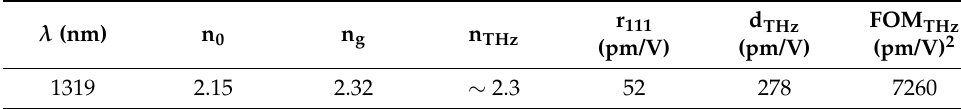
Figure 15. Optimum crystal length l opt ( ν , λ ) for the generation of THz waves as a function of the pump optical wavelength, and the frequency of the generated THz wave for OH1 for both pump and THz waves polarized along the polar axis. Used with permission from the Royal Society of Chemistry, from [195]; permission conveyed through Copyright Clearance Center, Inc. Table 19. Main optical-THz characteristics of